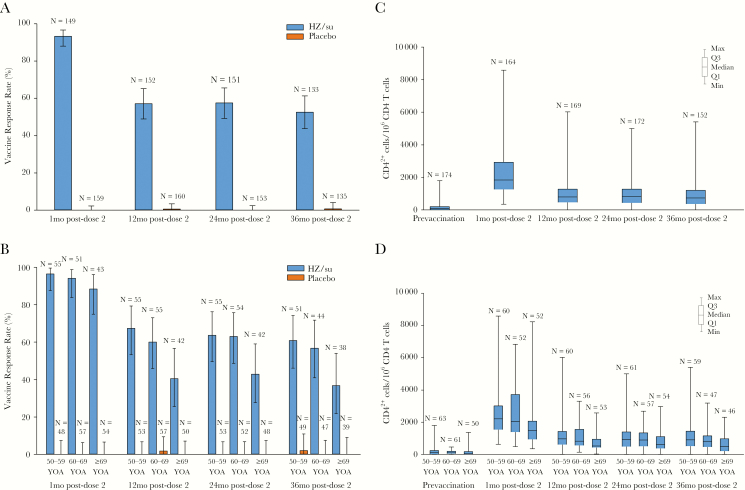
Herpes zoster subunit vaccine (HZ/su)-induced glycoprotein E-specific cell-mediated immunity (according-to-protocol cohort for cell-mediated immunogenicity): percentage of responders overall (A), percentage of responder by age (B), CD42+ frequencies overall (C), CD42+ frequencies by age (D). Only HZ/su is shown is panels C and D. Abbreviations: mo, month; N, number of participants with available results; YOA, years of age. Error bars depict 95% confidence intervals (A and B) or minimum and maximum values (C and D).